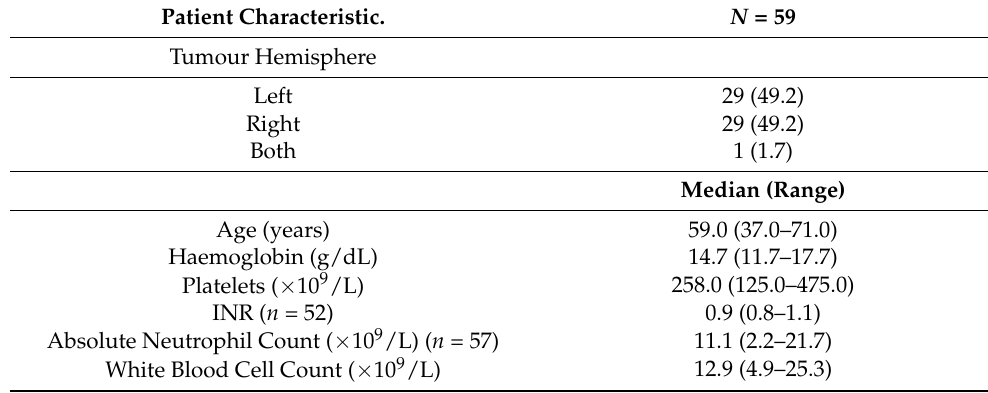
Table 1. Cont. Patient